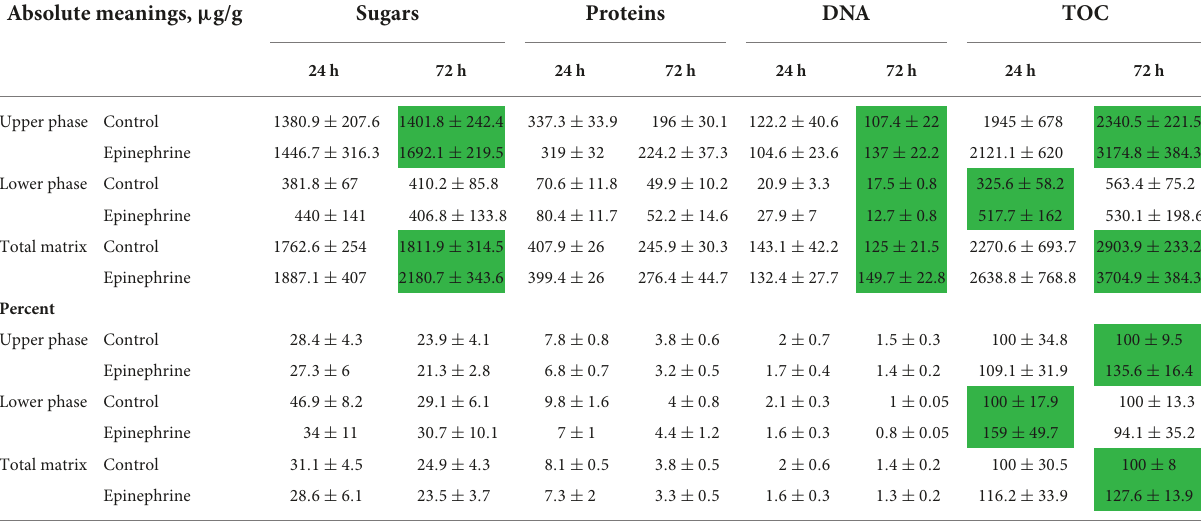
TABLE 1 Biochemical composition of M. luteus C01 matrix in the presence of epinephrine and in control samples. Absolute meanings, µ g/g Sugars